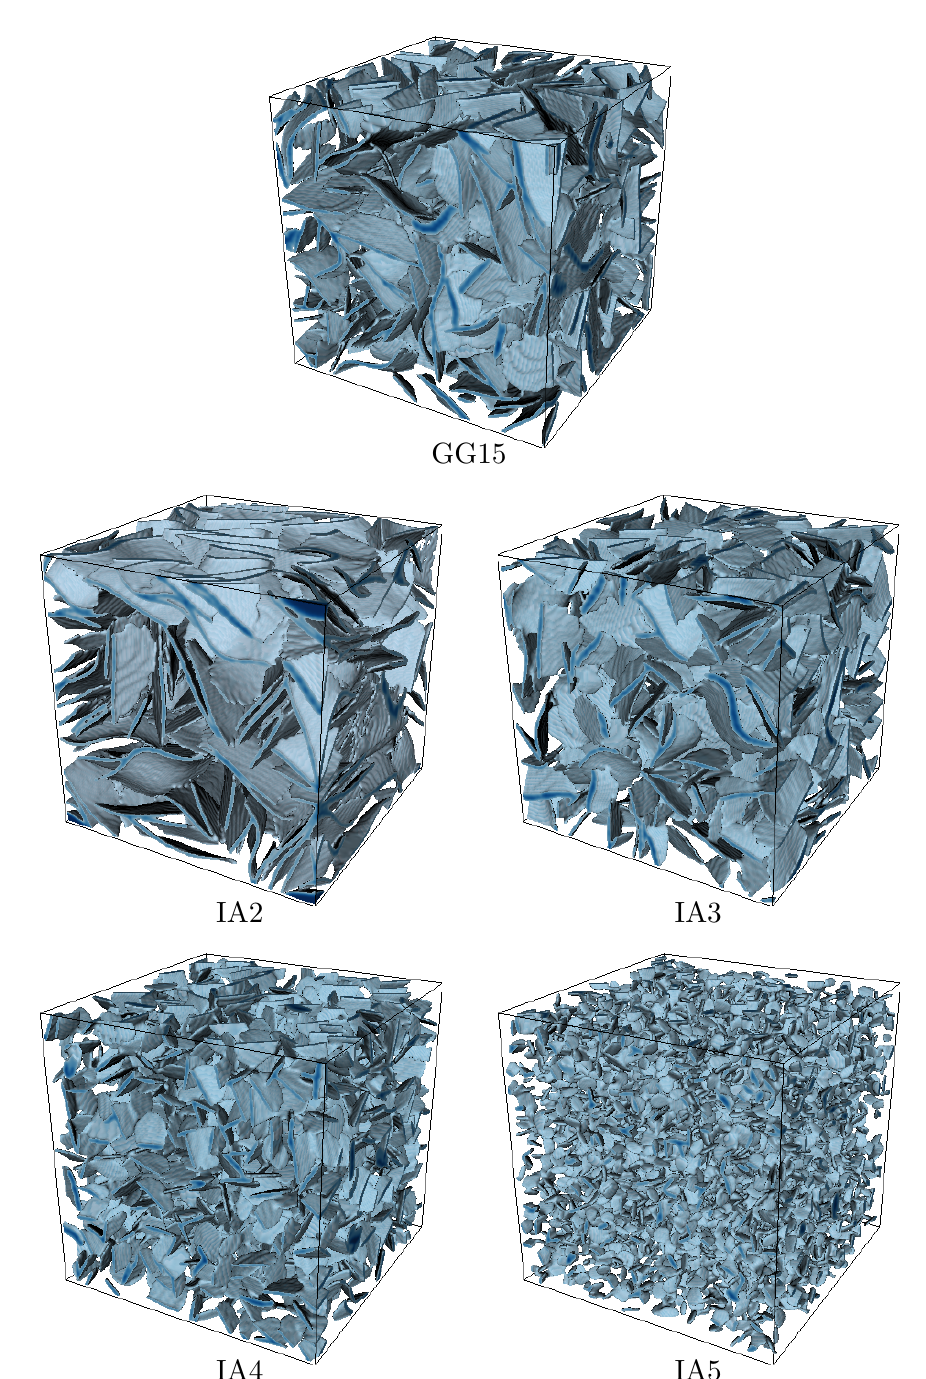
Figure 4. Spatial images of the graphite morphology of statistical volume elements of different graphite characteristics. The simulation domains have a spatial extent of 1.25mm 1.25mm, for a spatial discretisation using voxels of size 5µm flake volume fraction of 10v.